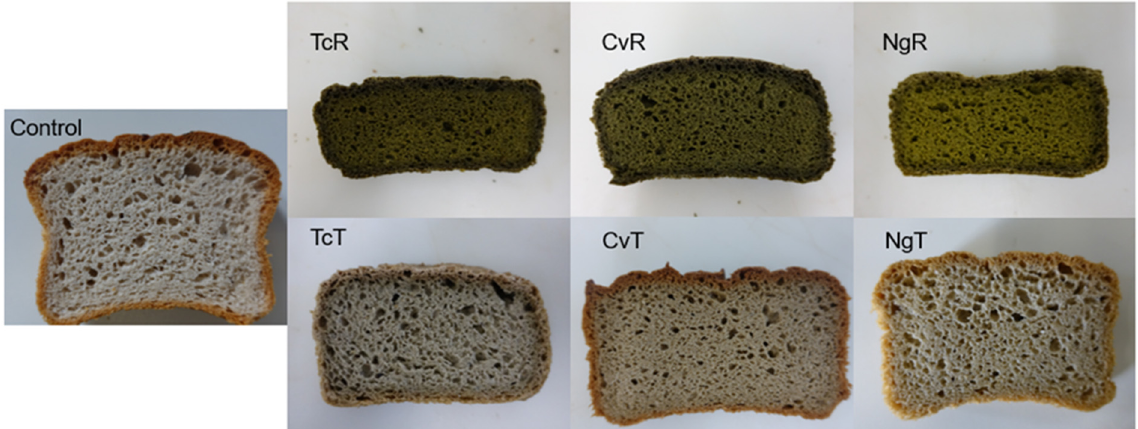
Figure 6. Images of the gluten-free bread with the 4% replacement of microalgae’s: Tetraselmis chuii (TcR), Tetraselmis chuii ethanol-treated (TcT), Chlorella vulgaris (CvR), Chlorella vulgaris ethanol-treated (CvT), Nannochloropsis gaditana (NgR), and Nannochloropsis gaditana ethanol-treated (NgT). Table 6. Bread crumb and crust color parameters. Tetraselmis chuii (TcR), Tetraselmis chuii ethanol- treated (TcT), Chlorella vulgaris (CvR), Chlorella vulgaris ethanol-treated (CvT), Nannochloropsis gaditana (NgR), and Nannochloropsis gaditana ethanol-treated (NgT). Crumb Crust